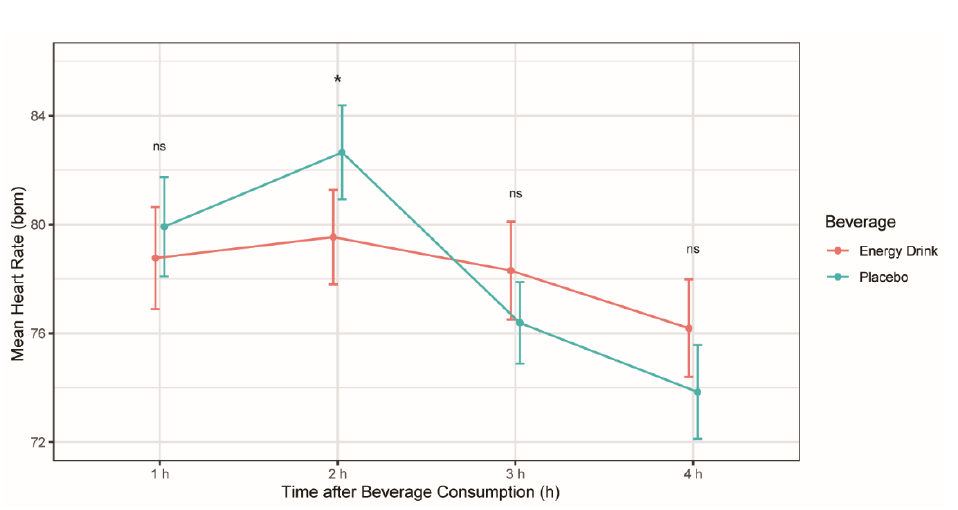
Table 3. QTc lead 1 and QTc lead 2 ( n = 26) .